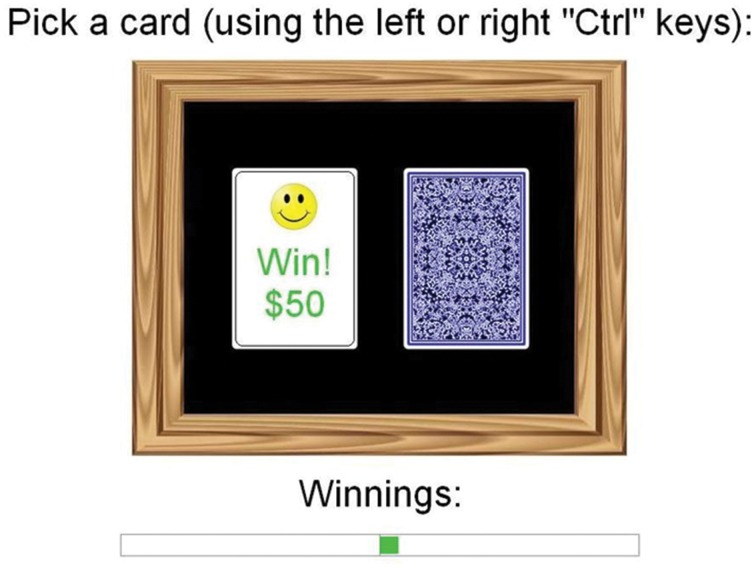
Screen shot of the Auckland Card Task (Condition 1). The participant has just pressed the left control key and received a $50 reward.